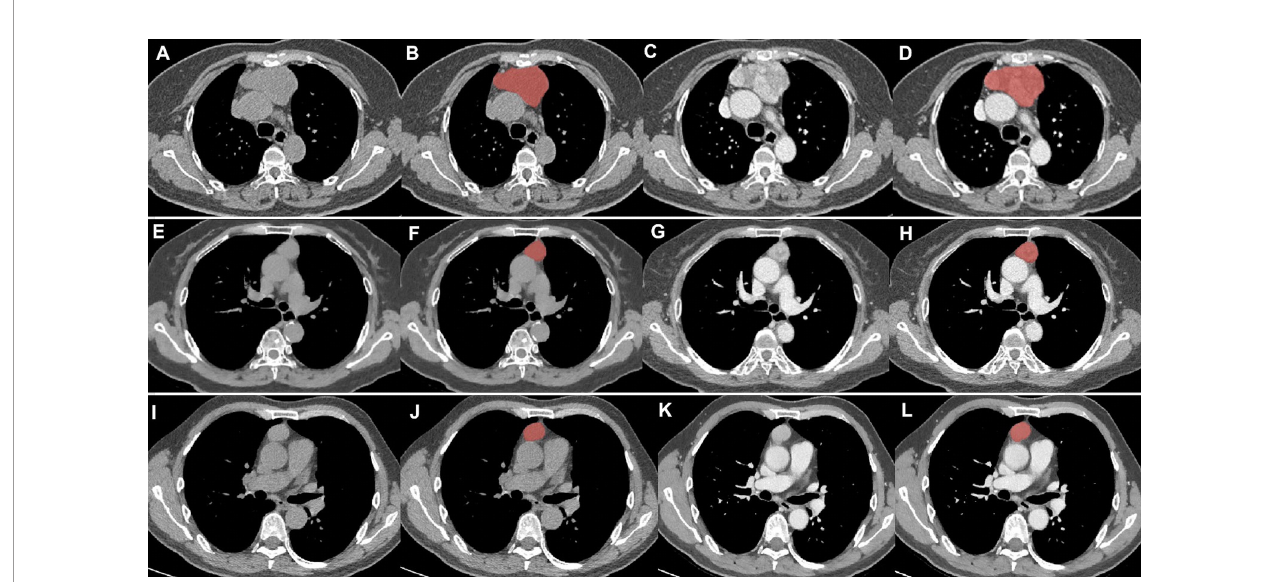
FIGURE 2 | Tumor segmentation. (A – D) thymic carcinomas; (E – H) high-risk thymomas; (I – L) , low-risk thymomas. Columns 1 and 2 were the NECT scan, columns 3 and 4 were the CECT scan. Columns 2 and 4 showed the delineation of different lesions (red